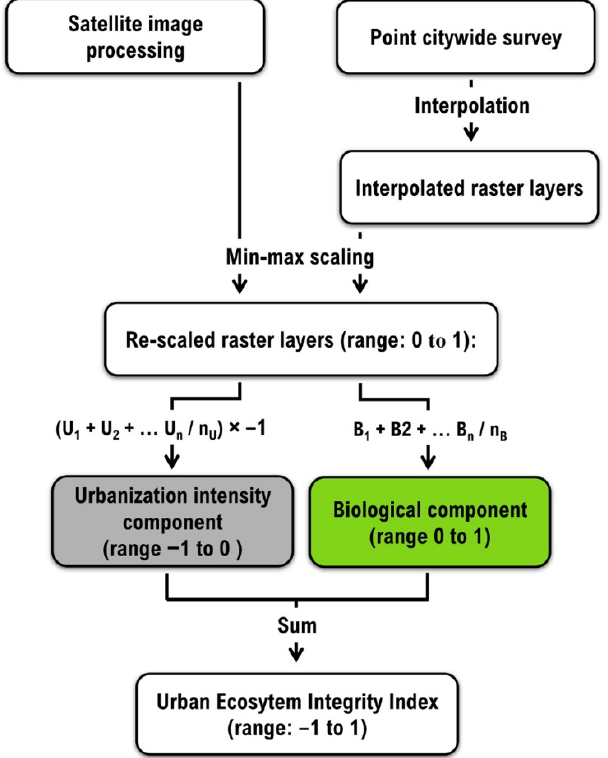
Figure 2. Flowchart for the quantification of the Urban Ecosystem Integrity Index (UEII).